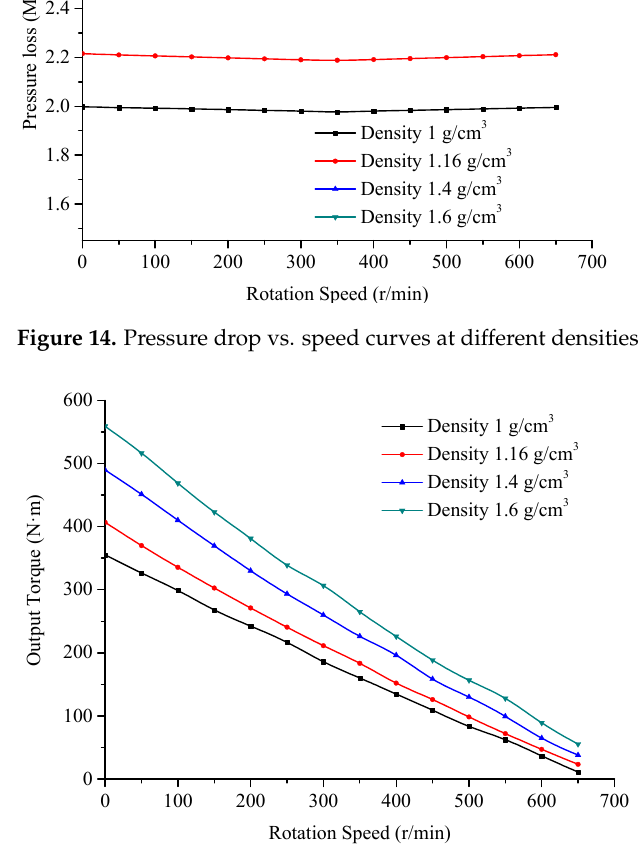
Figure 15. Torque vs. speed curves at different densities.